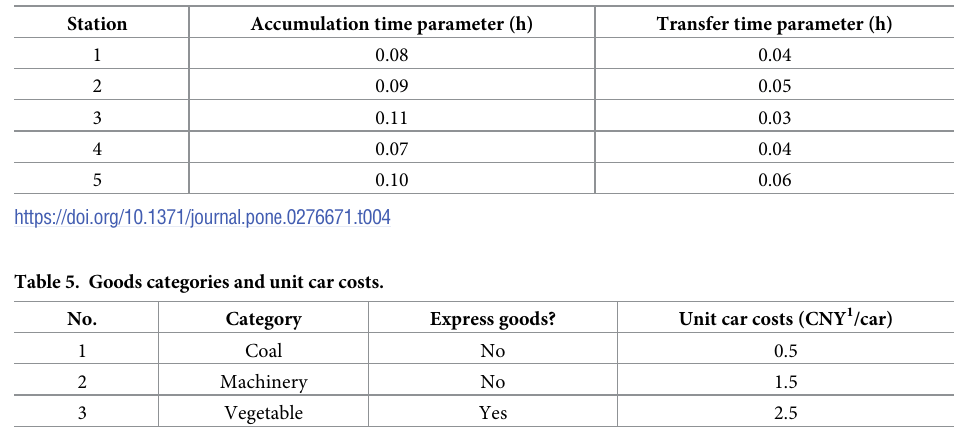
Table 4. Network stations and accumulation/transfer time parameters.